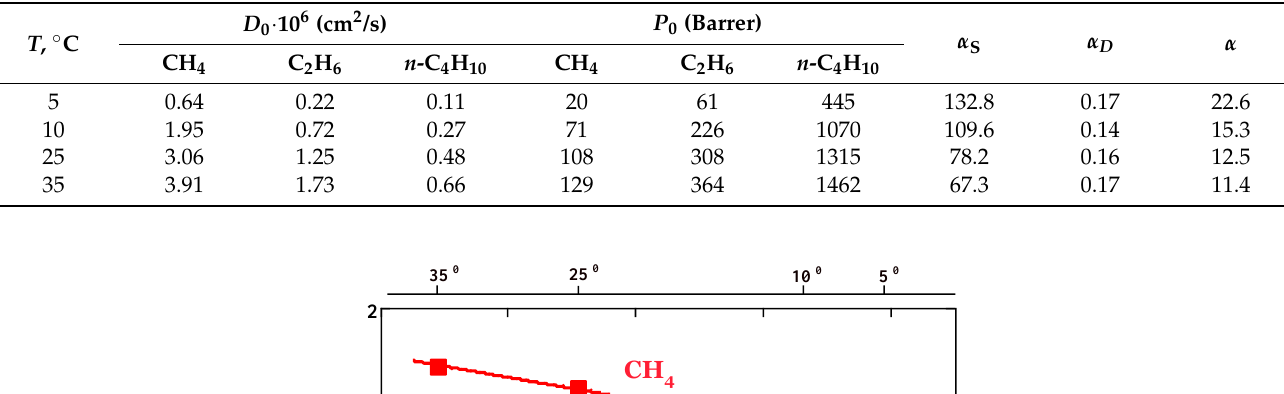
Table 2. Hydrocarbon diffusivity and permeability in PTDMS in the limit pressure p → 0. Ef- fect of temperature on n -C 4 H 10 /CH 4 solubility ( α S ), diffusivity ( α D ) and permeability ( α = α S · α D ) selectivities are also shown.